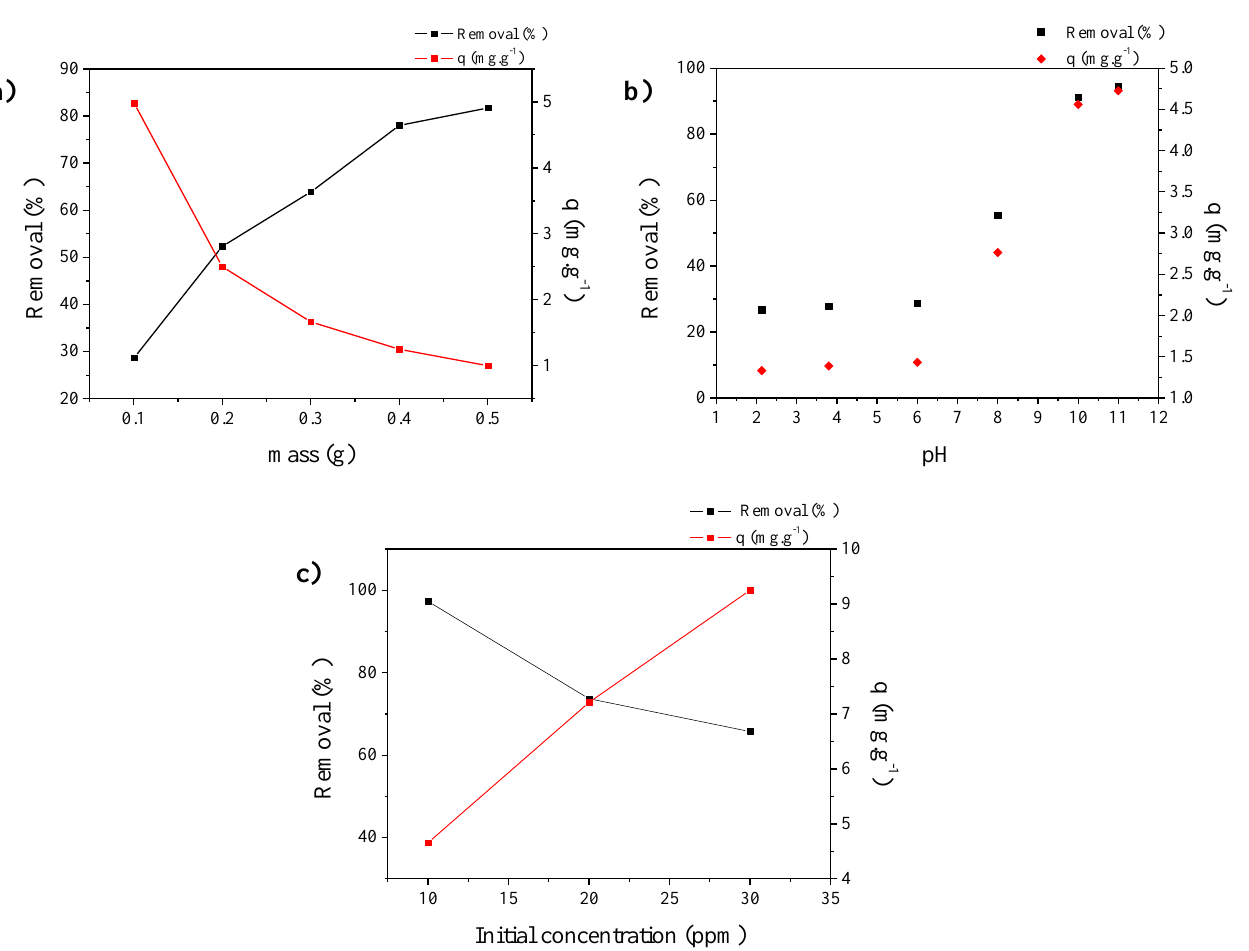
Figure 9. ( a ) Effect of mass on removal % and adsorption capacity; ( b ) effect of pH on removal % and adsorption capacity; ( c ) effect of the initial